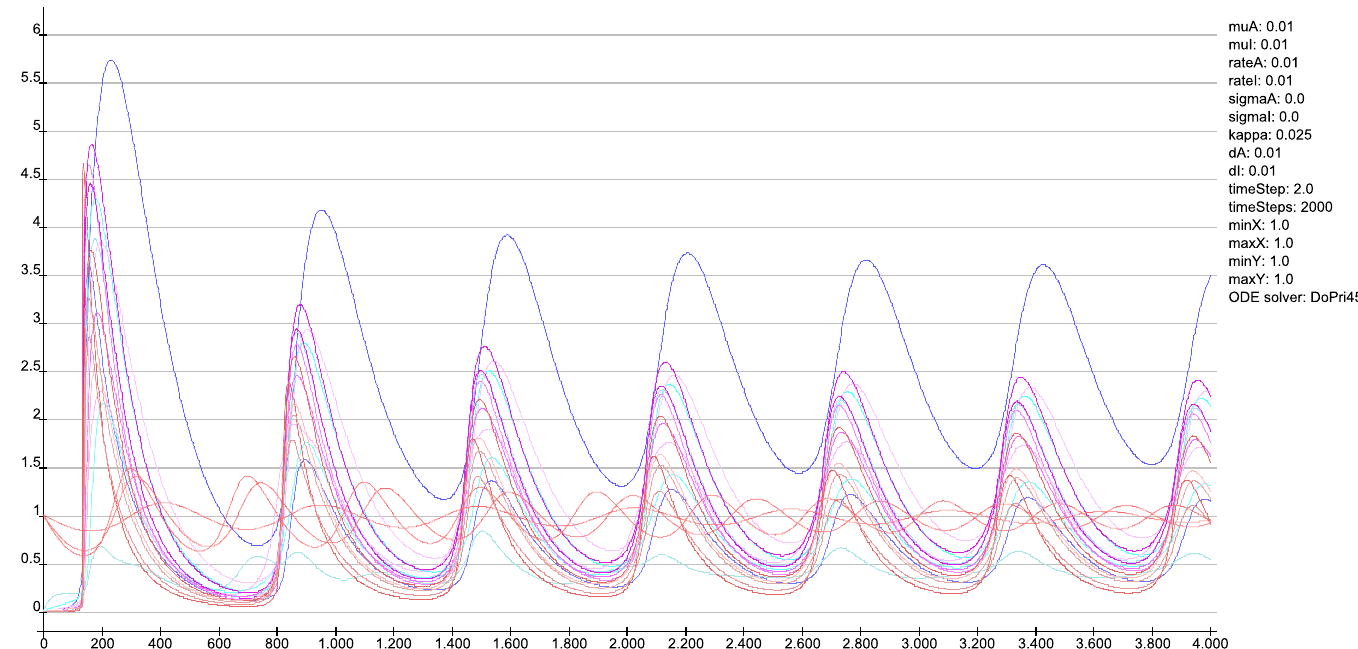
Fig 3. Functions of concentrations for regions of left side. The functions of concentrations of left hemispheric regions are shown for the GM RD-model. Initial conditions V 0 = 1 and W 0 = 1 were set for the dorsal root ganglia of the left side. The color coding of the functions in this diagram and all following function representations in diagram form are based on the color definition in the area hierarchy, which is simplified in the adjacency matrix in Fig 1. Thus, the colors of the columns and rows of the adjacency matrix represent the color scale of the functions. The x-axis shows the iteration steps of the function. On the y-axis the diffused concentrations are shown according to the applied models and functions. These axis assignments were also maintained uniformly for all subsequent function diagrams.